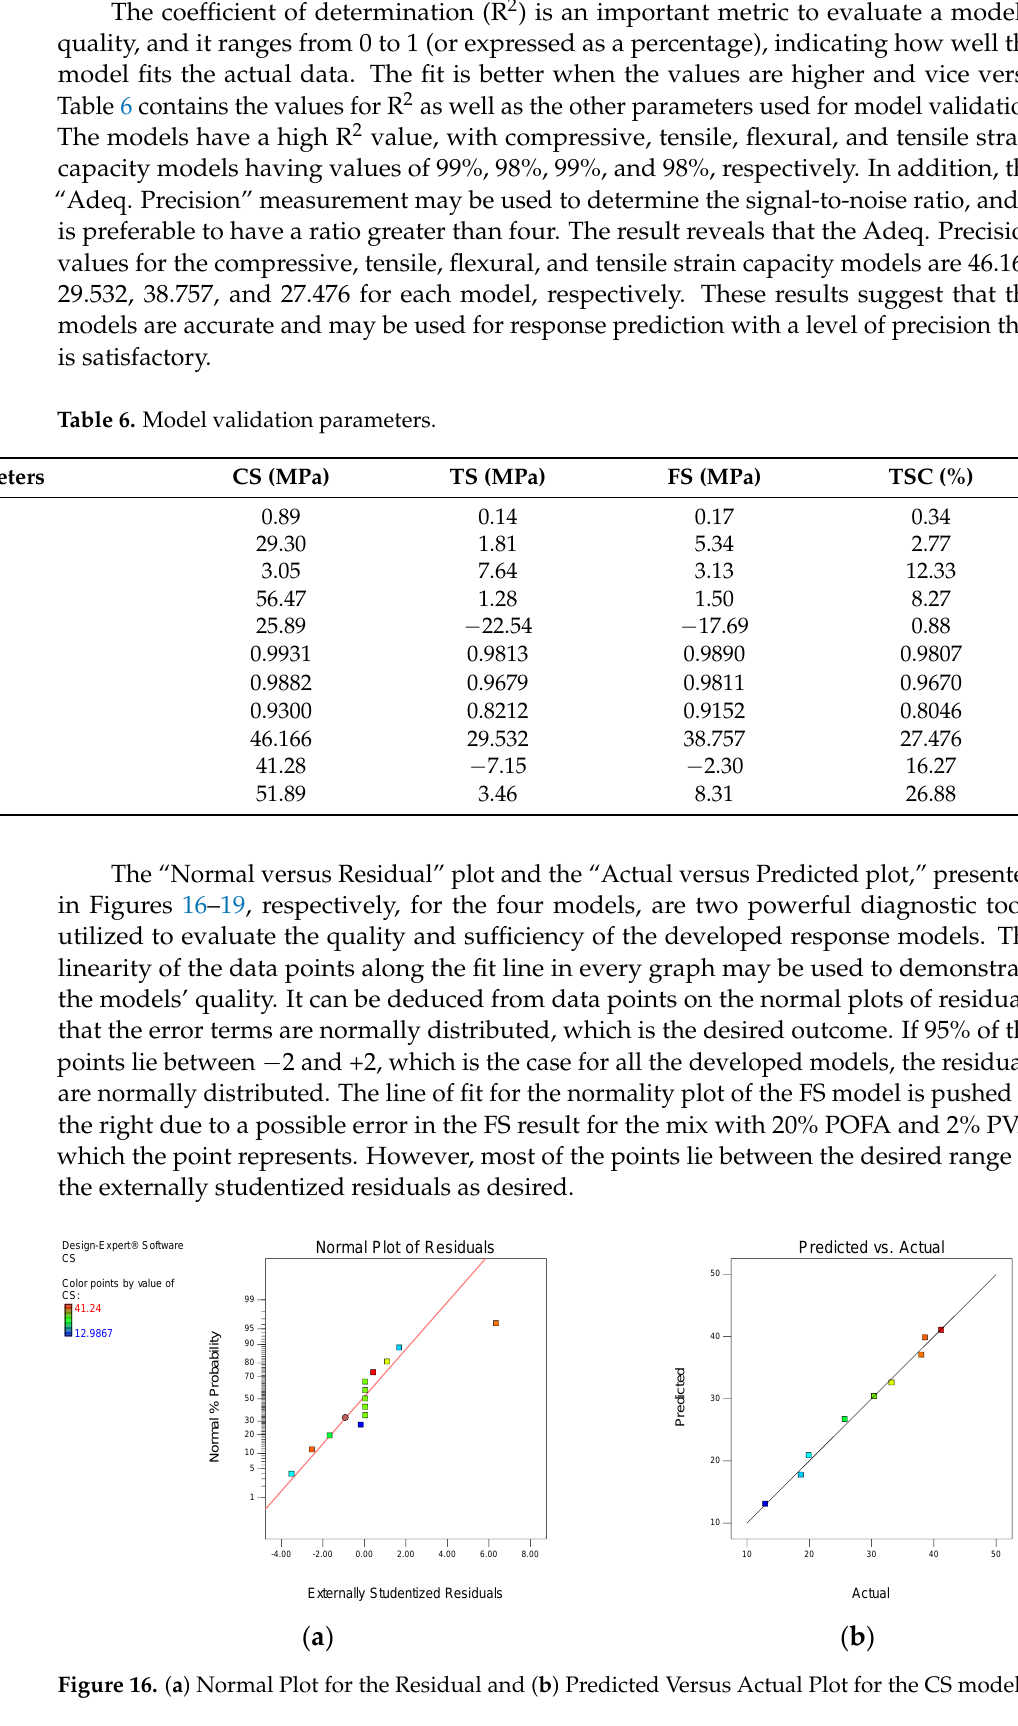
( a ) ( b ) Figure 17. ( a ) Normal Plot for the Residual and ( b ) Predicted Versus Actual Plot for the TS model. ( a ) ( b ) Figure 18. ( a ) Normal Plot for the Residual and ( b ) Predicted Versus Actual Plot for the FS model.